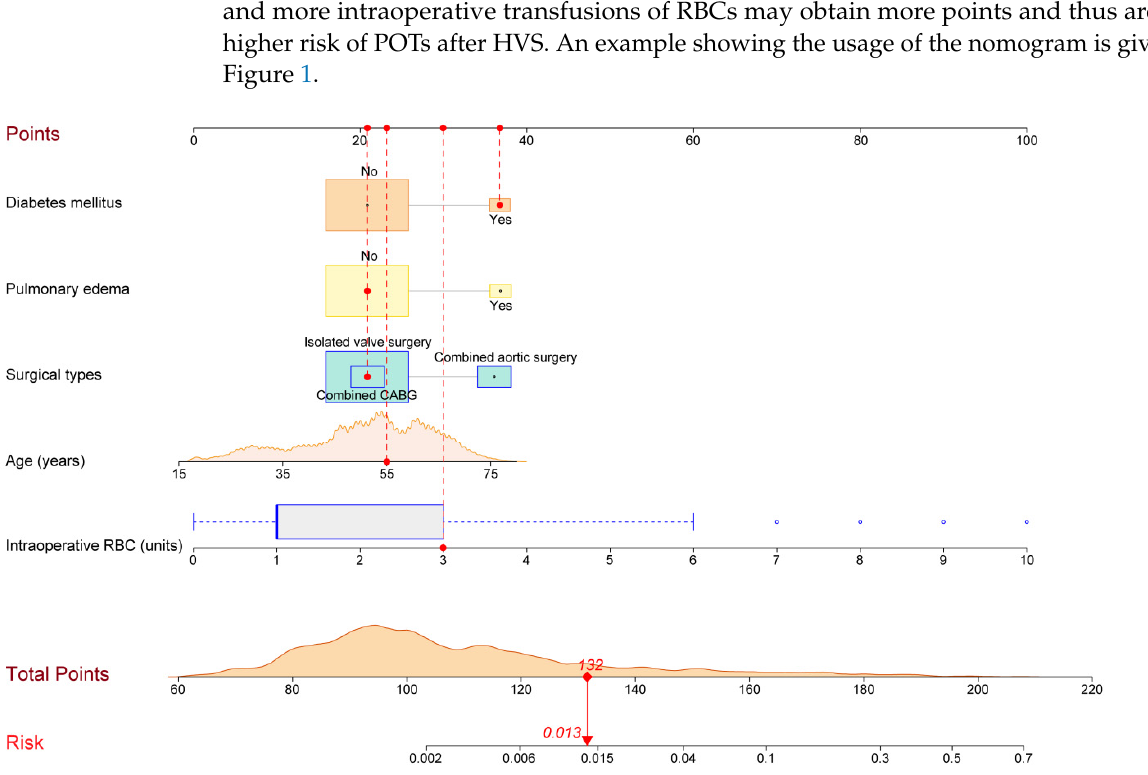
Figure 1. Nomogram for the prediction of postoperative tracheostomy after heart valve surgery. A specific patient was presented to show the usage of the nomogram. This was a 55-year-old patient with diabetes mellitus and without pulmonary edema. He underwent isolated valve surgery and was transfused with 3 units of RBCs intraoperatively. The individual item points corresponding to each variable are shown at the top, and the total scores are obtained from the sum of the points corresponding to each variable by a red dot. Given values of the five variables, the patient can be intuitively mapped onto the nomogram. It can be clearly seen from the nomogram that the total score of this patient was 132 points and the corresponding probability of POT was 0.013. RBC, red blood cell. The squares of each color represent a single variable: orange squares indicate diabetes mellitus, yellow squares indicate pulmonary edema, and blue squares indicate surgical types. To facilitate the usage of this system in modern clinical work, we further created an internet-based risk calculator (available at https://pothvs.shinyapps.io/dynnomapp/, ac- cessed on 7 December 2022). When using this online predictive system, we only need to choose the information of the patient and then click the “Predict” button; the estimated risk of POTs after HVS is calculated in the “Graphical summary” area on the right (Figure 2). When calculating the risk of another patient, one can simply change the information on the left. This makes it possible to assess the risks of multiple patients simultaneously, as well as the risk comparison among different patients. The specific information of the patients and the model can also be obtained by clicking the “Numerical summary” and “Model summary” on the right. When a user cannot log in with a new device, we recom- mend logging out first by pressing the “Quit” button at the left bottom and then reloading the procedure.